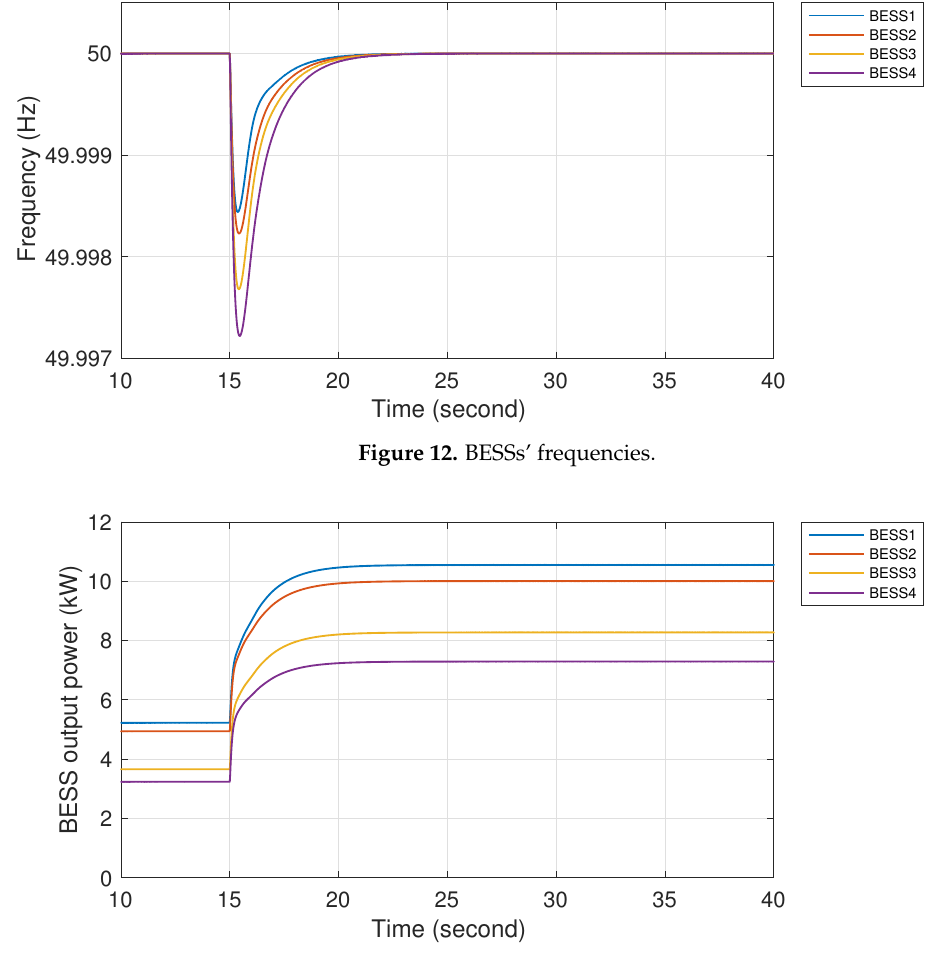
Figure 13. BESSs’ active